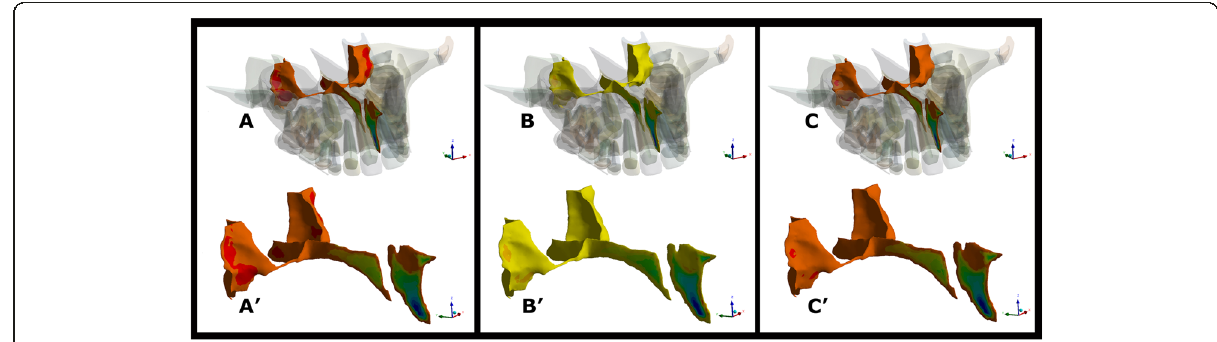
Fig. 3 Principal stress distribution pattern. a MinPS — anatomic model view. a ′ MinPS — isolated view of the midpalatal suture. b MidPS — anatomic model view. b ′ MidPS — isolated view of the midpalatal suture. c MaxPS — anatomic model view. c ′ MaxPS — isolated view of the midpalatal